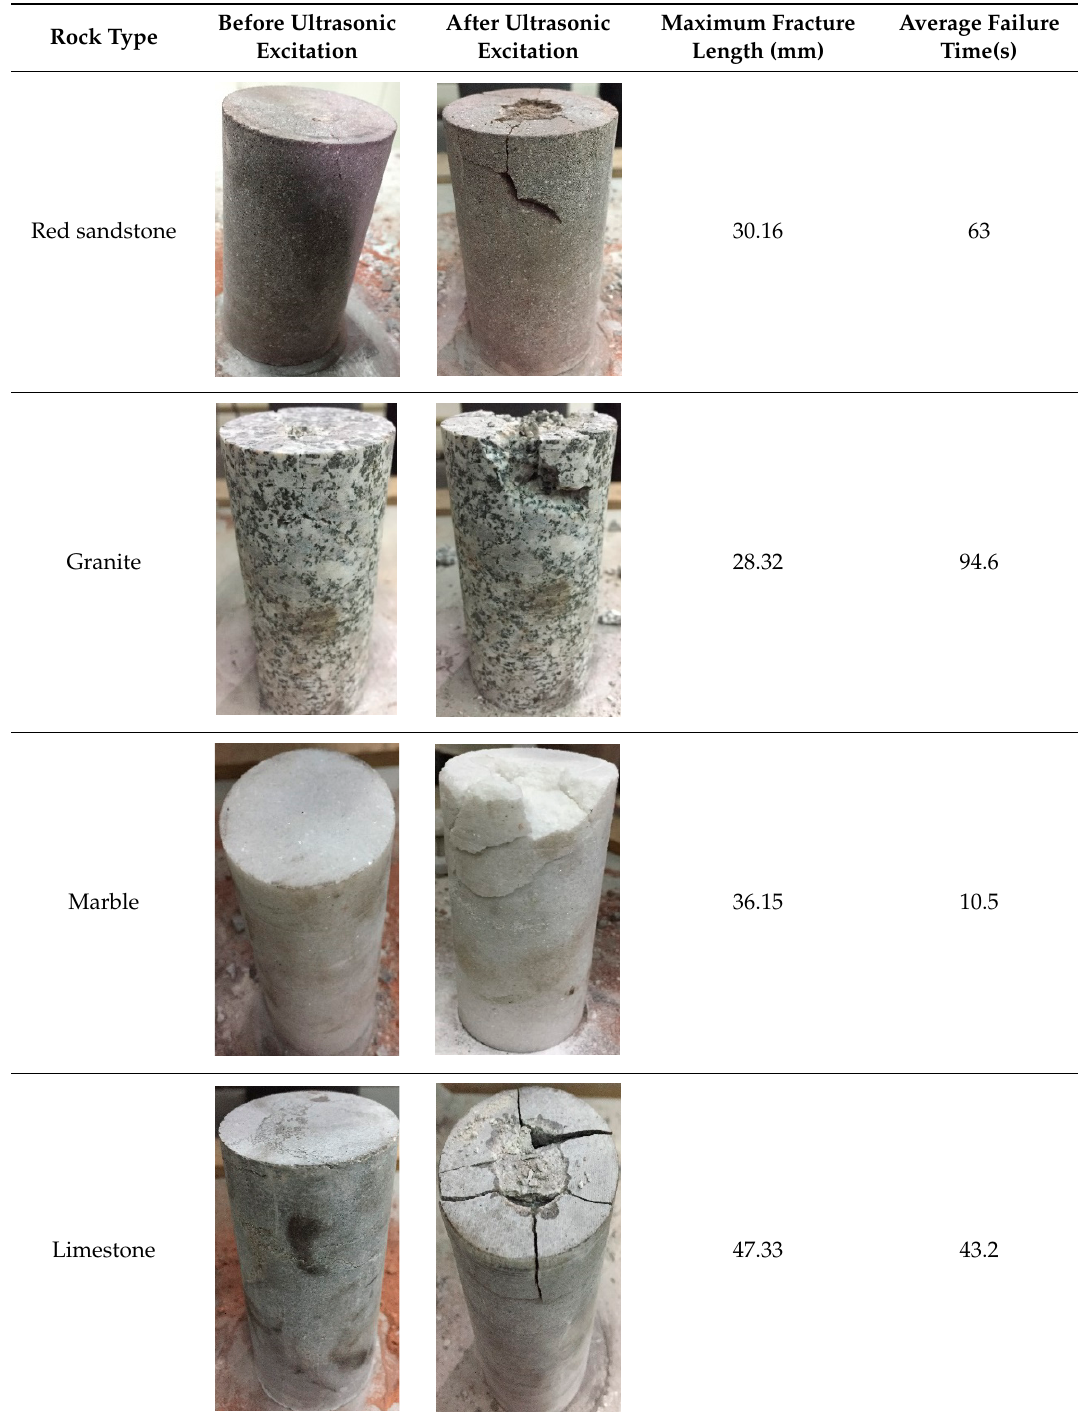
Table 3. Failure of different rock types under ultrasonic excitation.